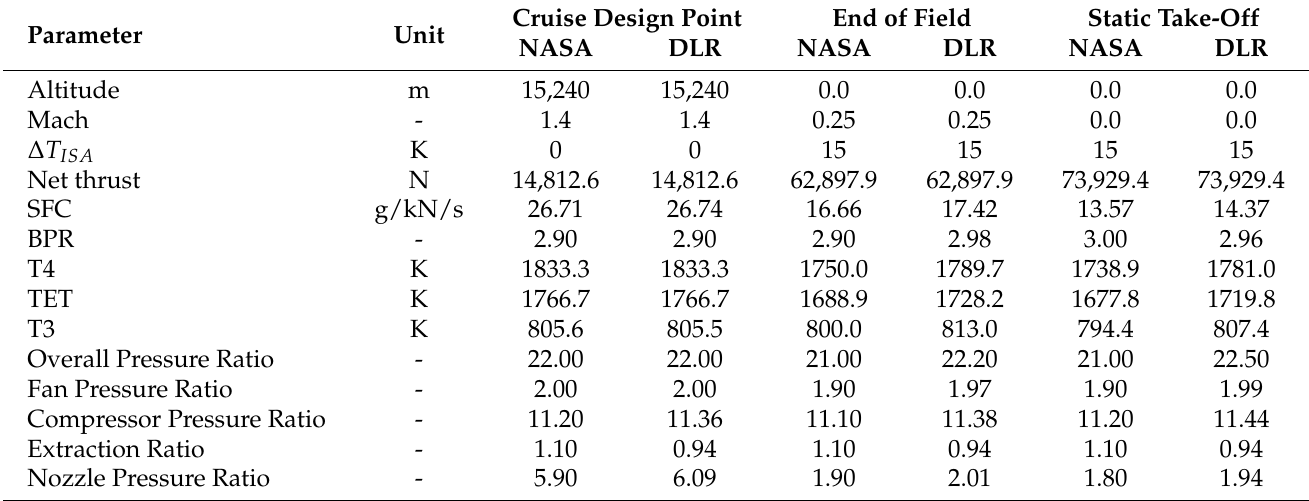
Table 2. Engine performance summary compared to data published by NASA